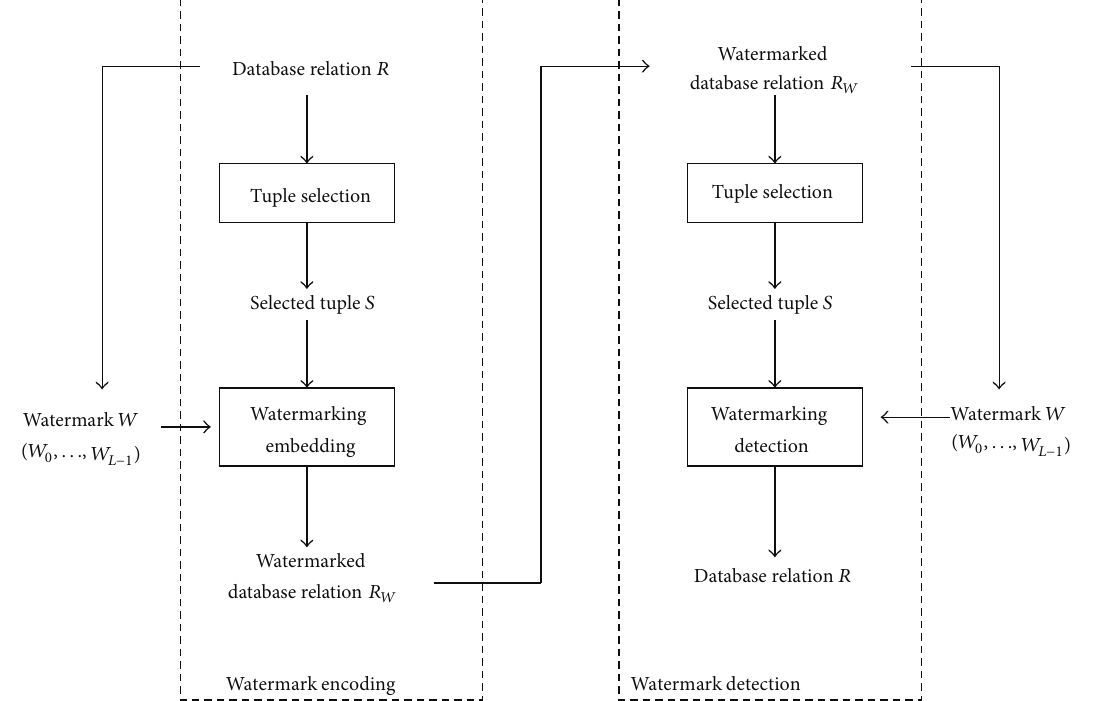
Figure 2: Flowchart of main processes in the proposed